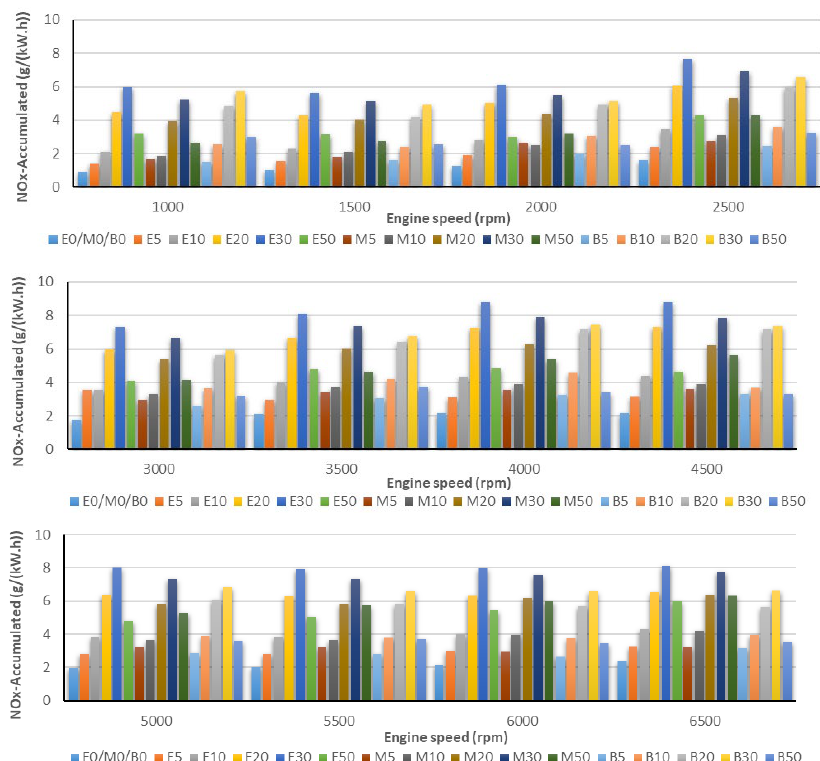
Figure 5. The results for HC emissions obtained by blended alcohols fuels and net gasoline.